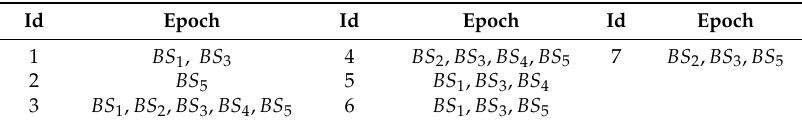
Table 3. A Sensor Database